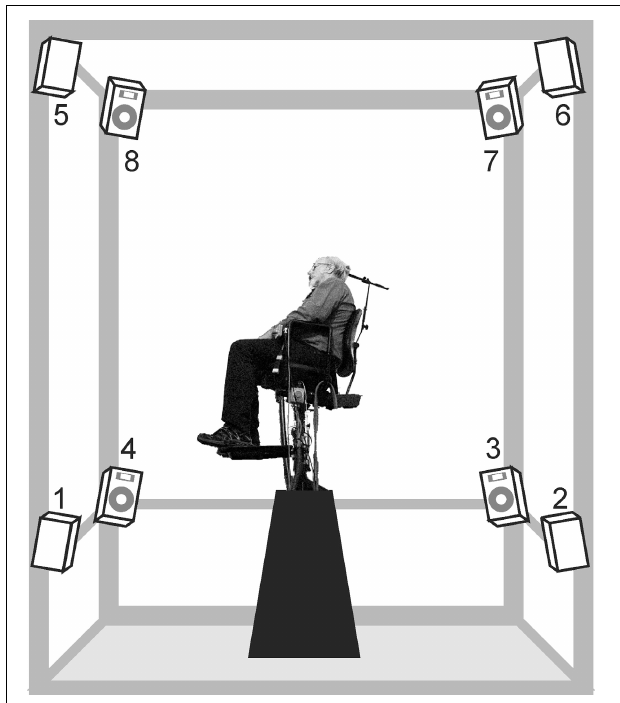
FIGURE 2 | Setup for sound-localization testing.